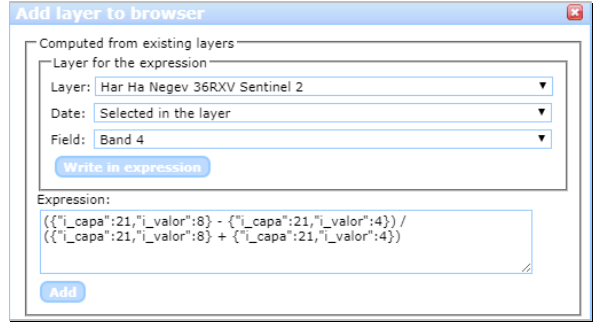
Figure 4. HTML representation of a JavaScript generated window to define calculations from existing layers.